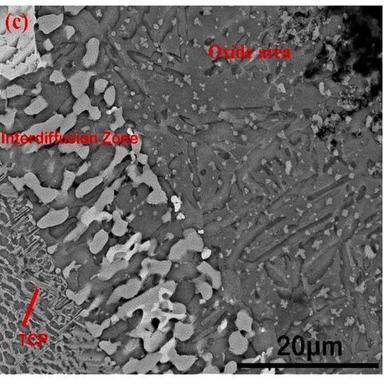
The degraded internal coating after long time operation (55,000 h) at the 50% height of TE.